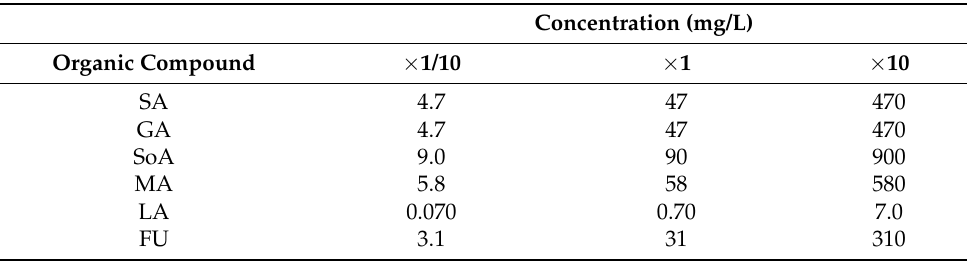
Table 1. Organic compound concentration (mg/L) of salicylic acid (SA), gallic acid (GA), sodium alginate (SoA), mannitol (MA), laminarin (LA), and fucose (FU) applied in seeds and tomato